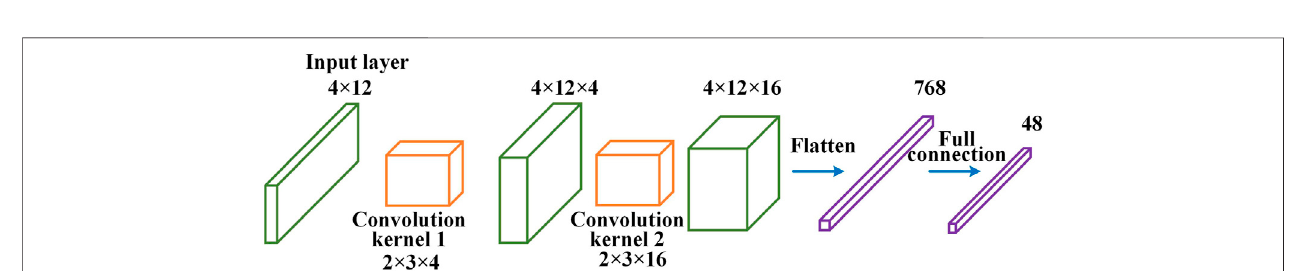
FIGURE 3 | EM-WS-CNN overall framework.